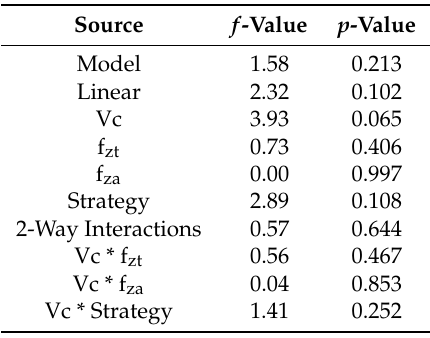
Figure 16. E ff ect plot for burr height. Figure 16. Effect plot for burr height. Table 12. Variance analysis for burr height. Table 12. Variance analysis for burr height.